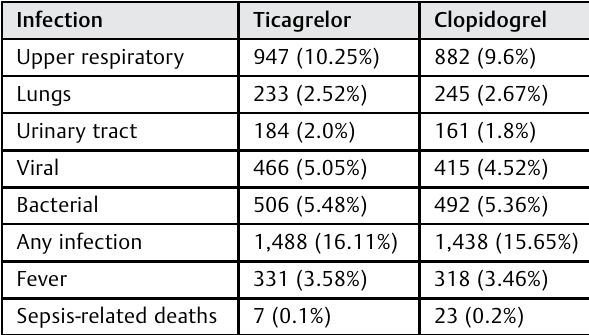
Table 1 FDA analyses of infections and sepsis-related deaths in